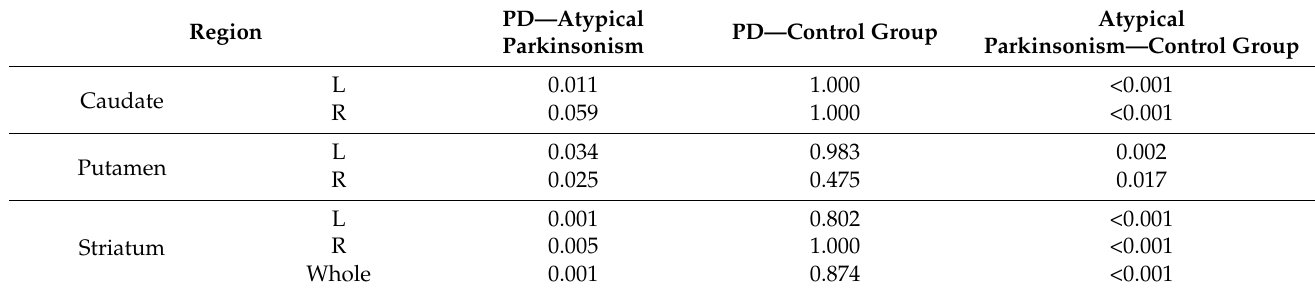
Table 3. Results of post hoc analyses comparing striatal SUVRs.